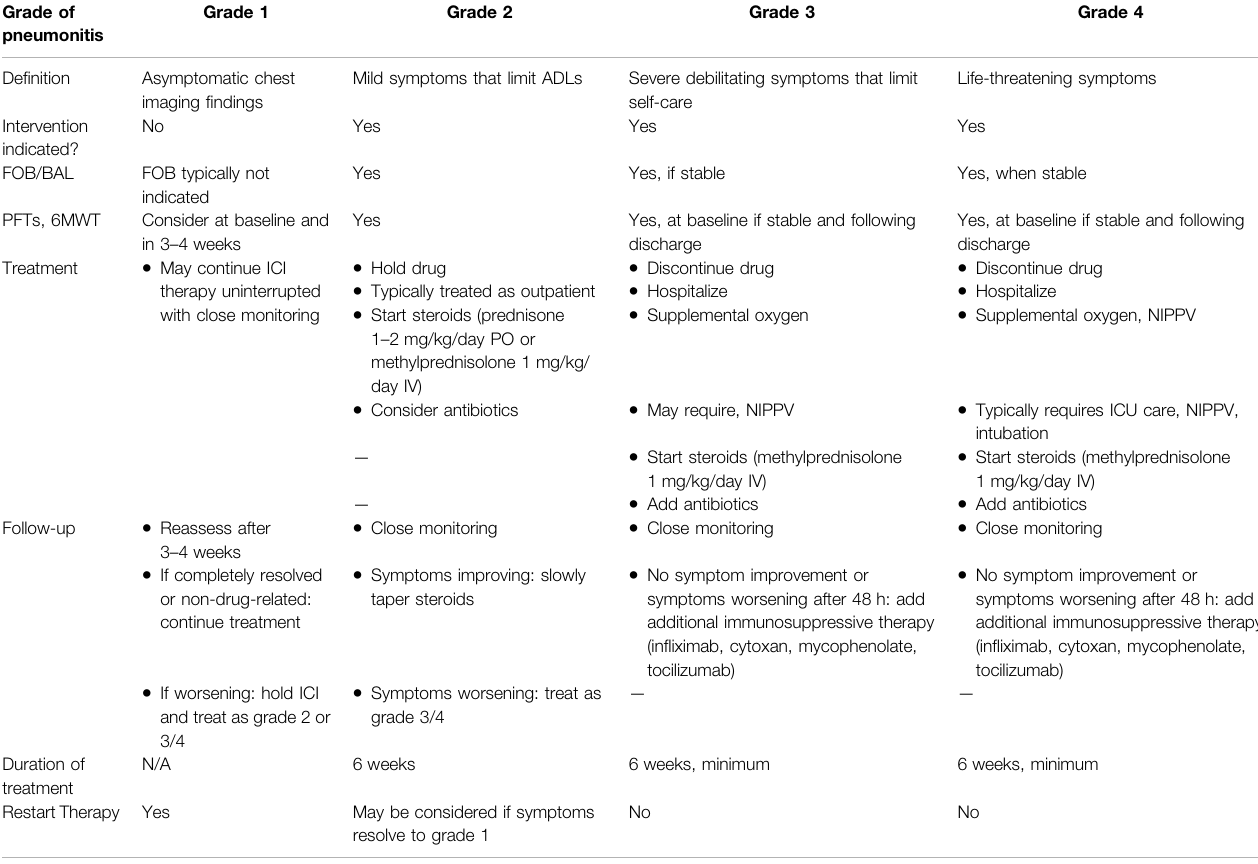
TABLE 4 | ICI-P: Diagnosis and treatment guidelines. Grade of